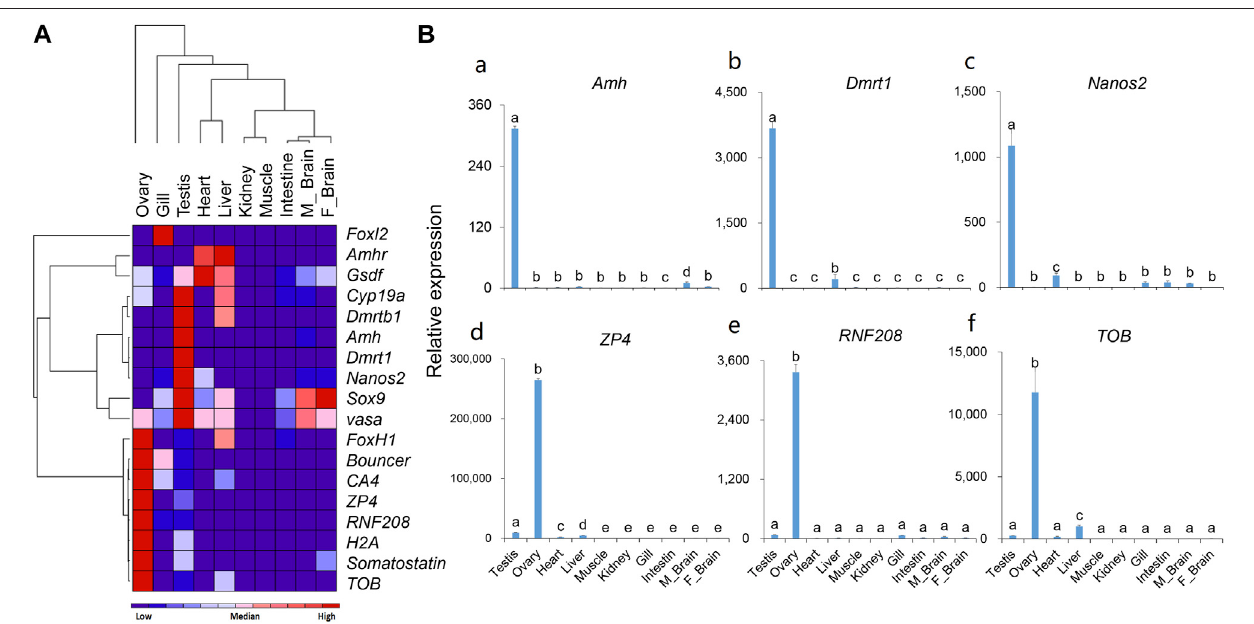
FIGURE 4 | The expression patterns of selected genes in different tissues of the rock bream. (A) Heat map of the expression patterns for 18 selected genes; Red indicatesrelativehighexpression,blueindicatesrelativelowexpression,andcolordepthindicatesrelativeexpressionlevels; (B) Detailedexpressionpatternsofselected genes (the histograms for the rest 12 genes are shown in Supplementary Figure S11